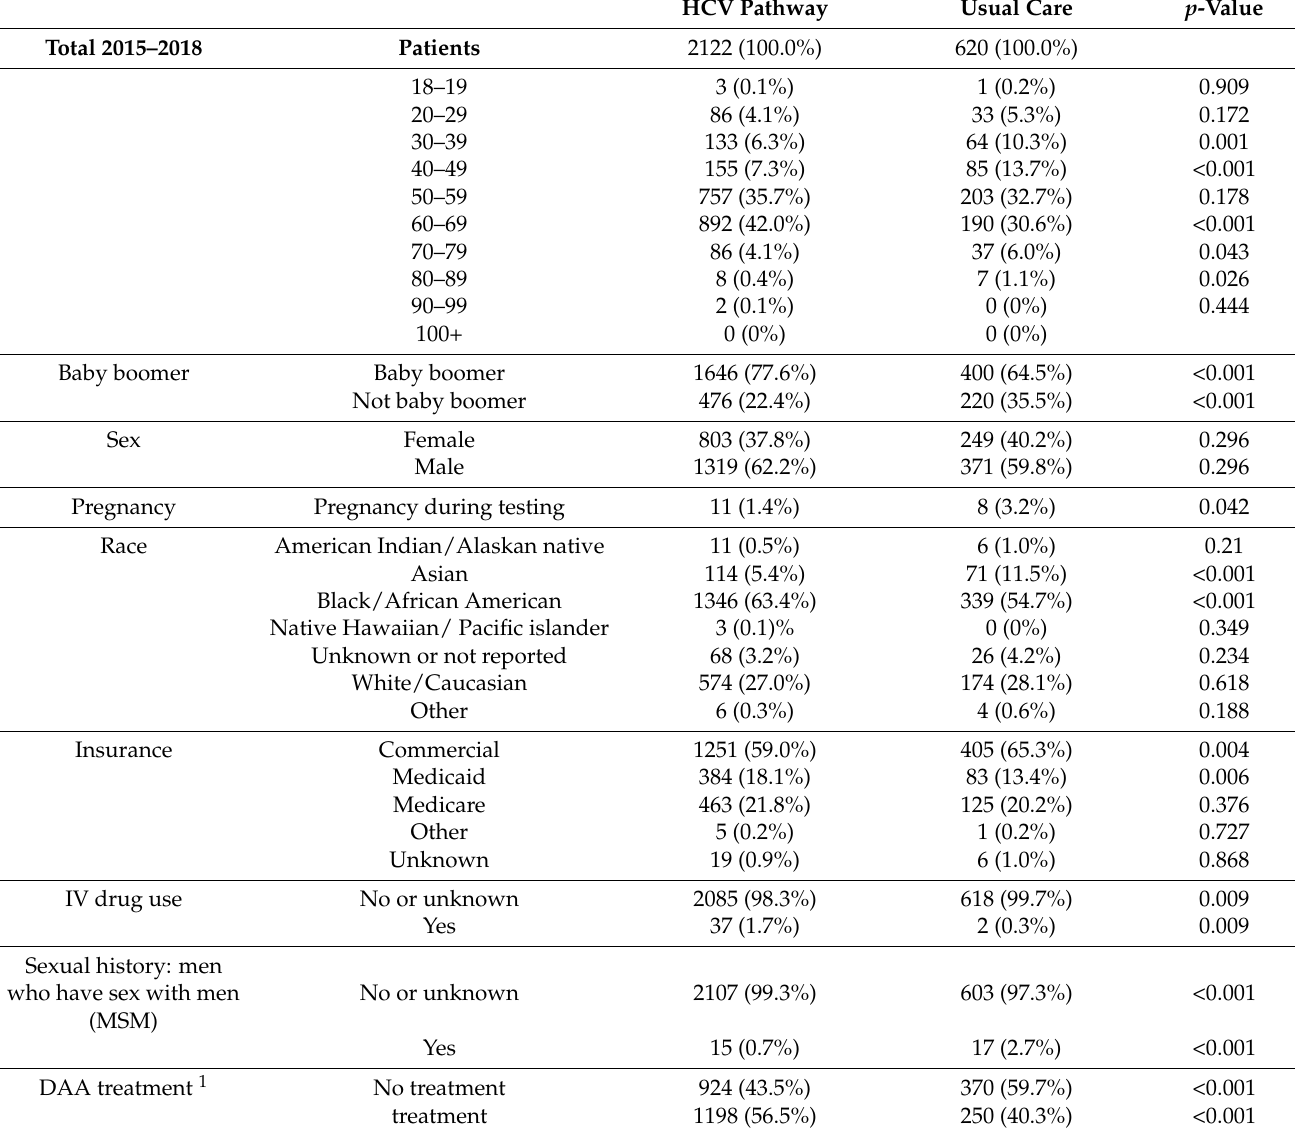
Table 2. Demographics of individuals tested positive for chronic HCV (HCV Antibody-positive and HCV RNA-positive; monoinfected): HCV pathway vs. usual